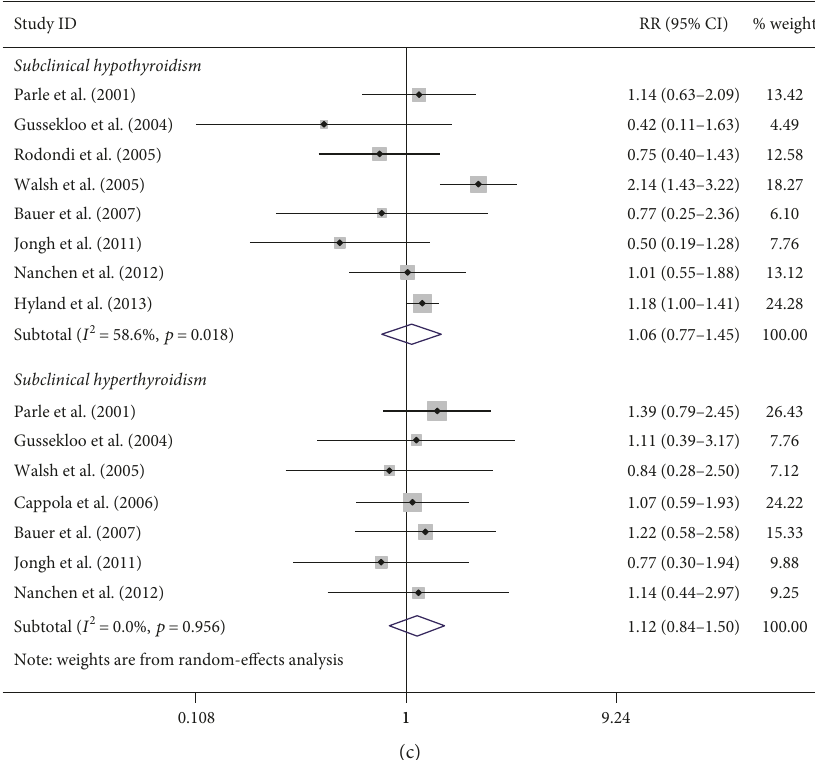
Figure 2: Forest plots for subclinical thyroid dysfunction. (a) Forest plots for subclinical thyroid dysfunction and risk of CHD; (b) forest plots for subclinical thyroid dysfunction and risk of total mortality; (c) forest plots for subclinical thyroid dysfunction and risk of cardiovascular